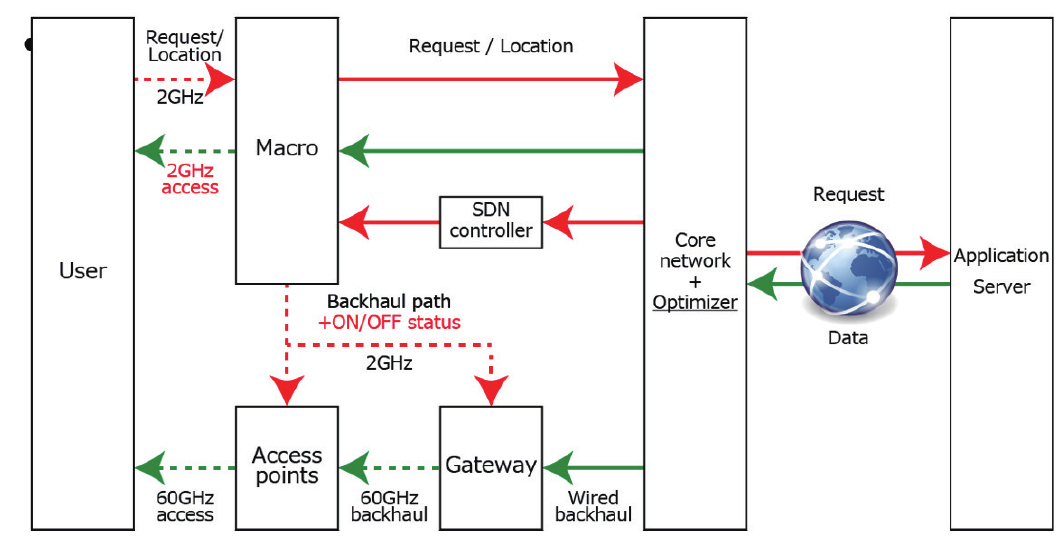
Figure 5. Proposed out-of-band C-plane (Network centric